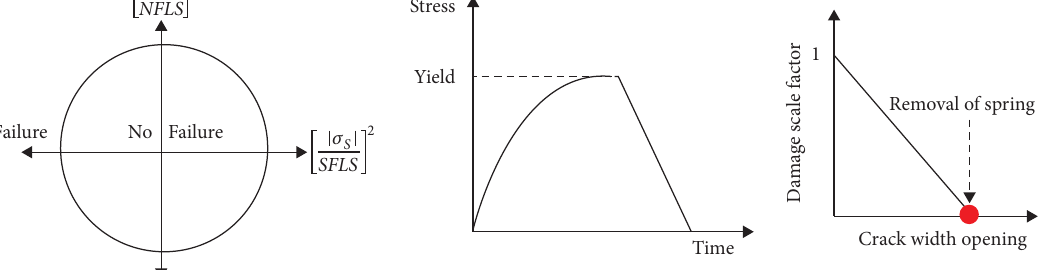
Figure 12: Spring failure criteria (Trapani et al. [48]).